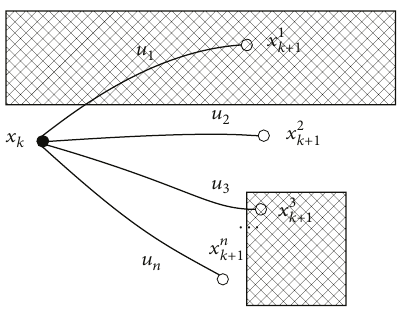
Figure 2: Latent expansion with